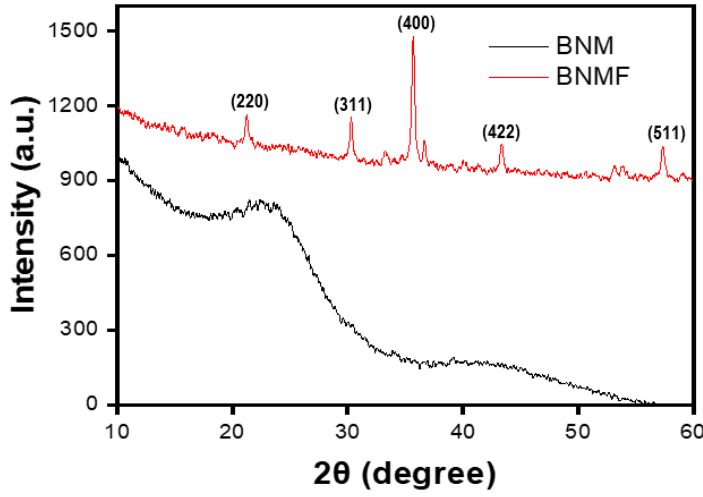
Figure 4. X-ray diffractograms of non-modified biochar (BNM) and ferromagnetic biochar (BNMF).